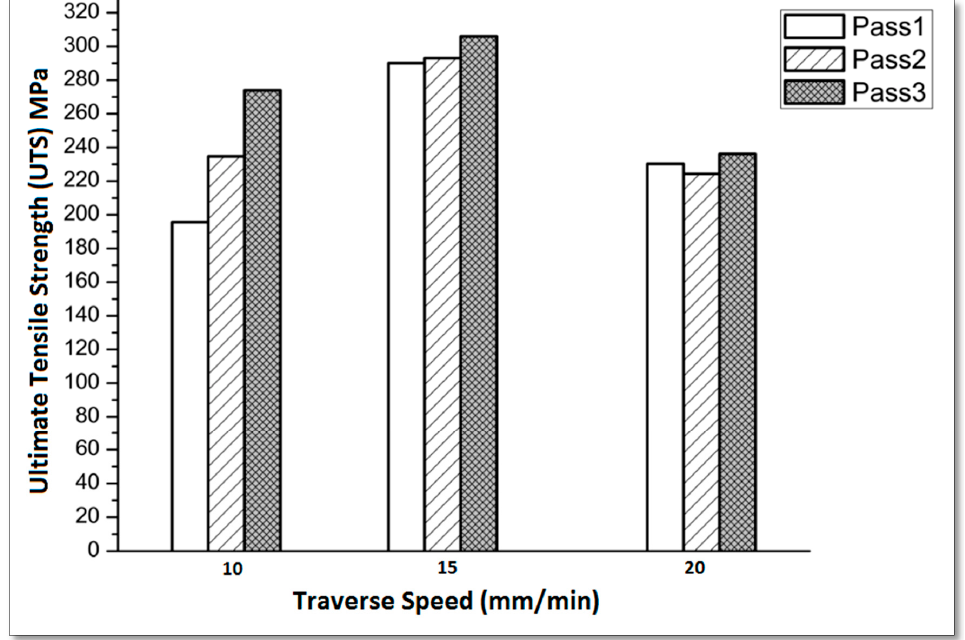
Figure 7. Effect of traverse speed on the maximum tensile strength at a constant rotation speed of 900 rpm for the three passes.